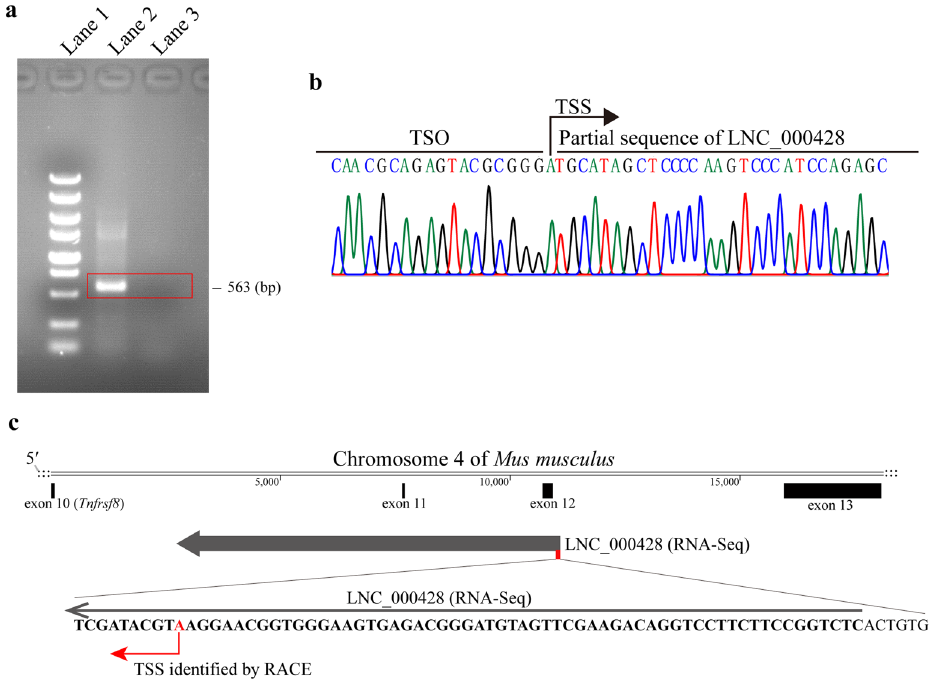
Figure 6. Determination of transcriptional start site (TSS) of LNC_000428 by 5 ′ RACE system. ( a ) The sizes of DNA products from RACE PCR determined by gel electrophoresis. Lane 1: DL5000 DNA marker (Vazyme); lane 2: RACE PCR of LNC_000428; lane 3: negative control of RACE PCR, its PCR template came from the reverse transcription reaction containing no reverse transcriptase. The original gel was displayed in the Supplemental Fig. 1. ( b ) The sequencing result of DNA products of RACE PCR. TSO = template-switching oligo. ( c ) Schematic draw of LNC_000428 TSS on the chromosome 4 of Mus musculus verified by 5 ′ RACE